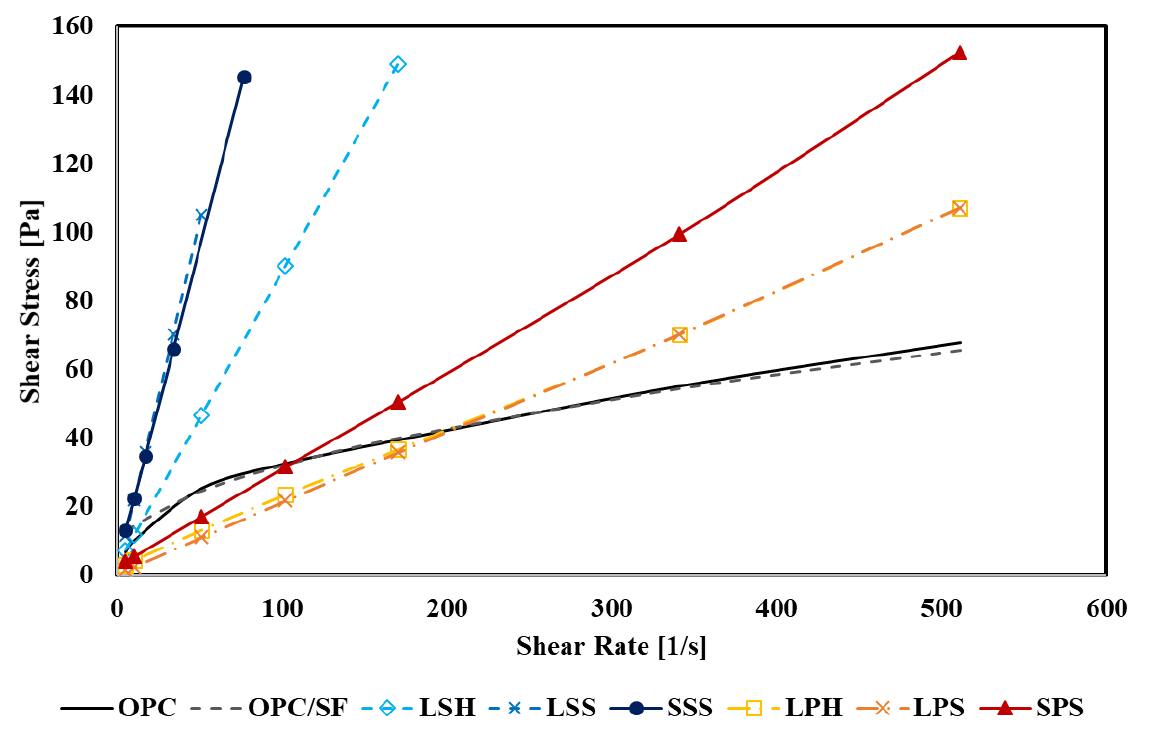
Figure 1. Viscosity profile for OPC and geopolymer slurries. Table 4. Rheological model parameters for OPC and geopolymer